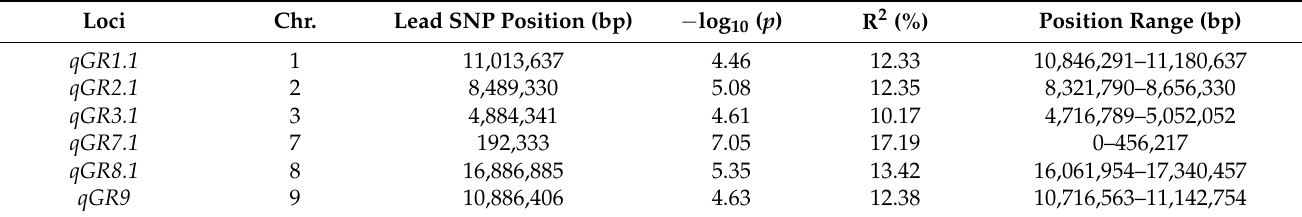
Figure 2. GWAS of seed germination in Japonica rice. Manhattan plots for germination rate at three days after imbibition in 2016 ( A ) and 2017 ( B ). The horizontal red lines represent a statistical significance threshold of − log 10 p = 4. The red arrows indicate that six stable loci were identified across two years. Table 2. Loci associated with germination rate in both two years.